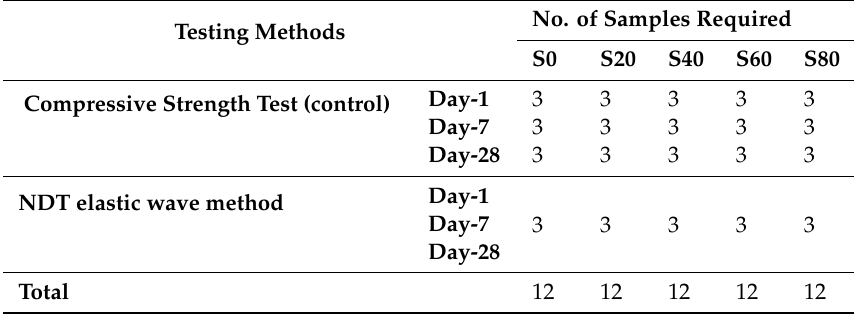
Table 2. Testing methods and the total number of concrete cube specimen